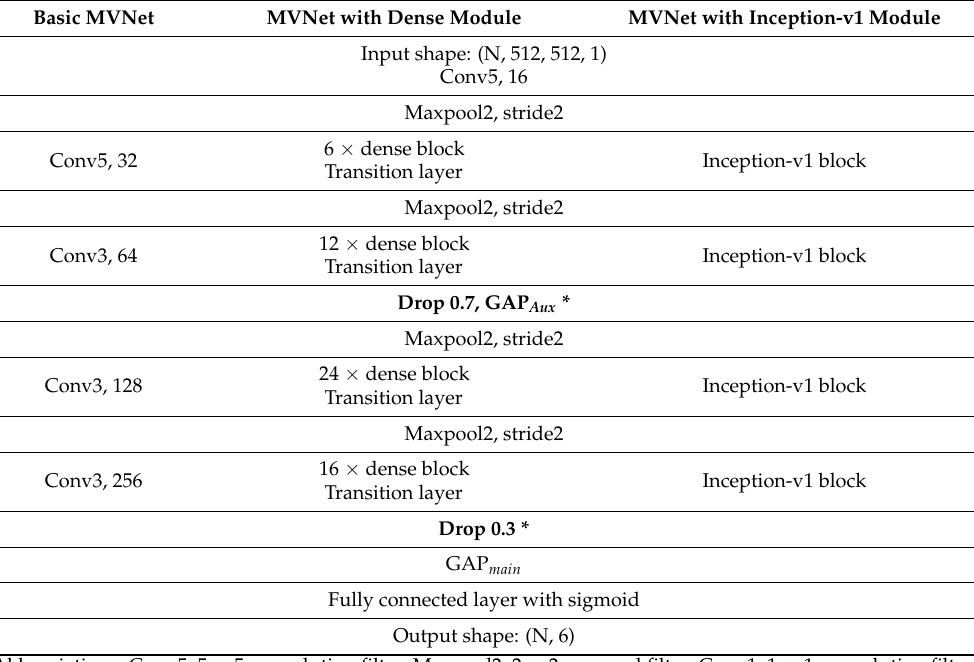
Table 1. Network architectures used to compare sinusitis classification performance.